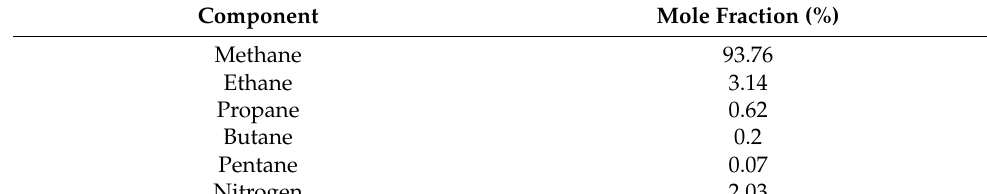
Table 2. Components of the natural gas phase.